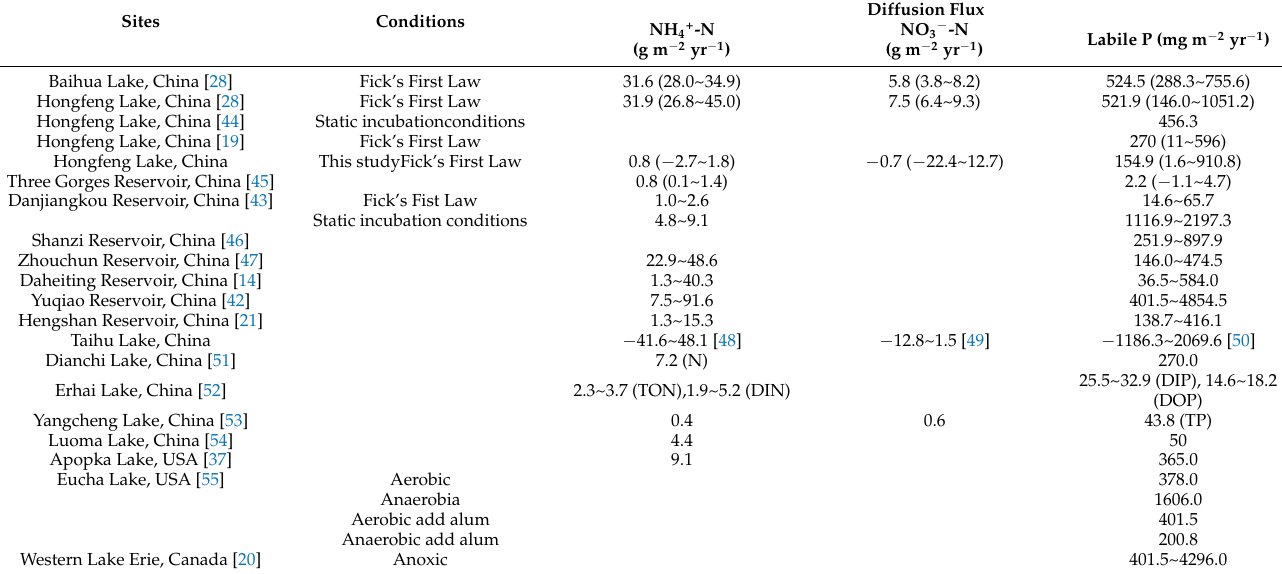
Table 3. The diffusion fluxes of labile P, NH 4+ -N and NO 3 − -N at SWI.